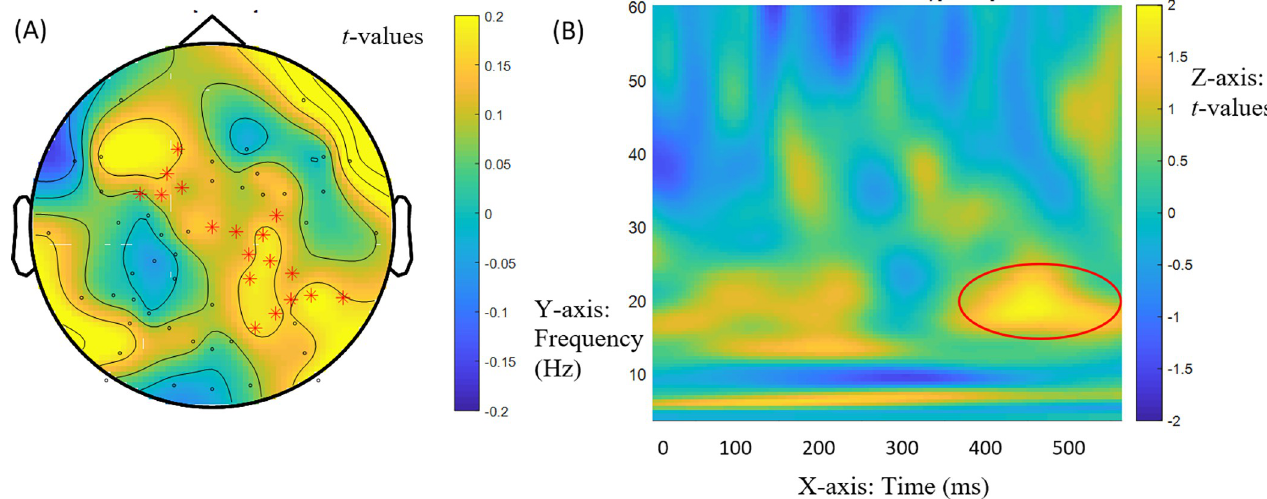
Fig 4. Group effects at subordinator que ‘that’ at 14-21Hz (beta band). (A) Group differences for the Mod-Comp contrast across antecedent match and mismatch [(2a+c)—(2b+d)] in induced power at subordinator que ‘that’ at 14-21Hz (beta band) between 382 and 562ms. The red marks indicate the electrodes for these effects (electrodes ‘E4’, ‘E9’, ‘E10’, ‘E11’, ‘E12’, ‘E13’, ‘E40’, ‘E41’, ‘E42’, E46’, ‘E48’, ‘E49’, ‘E50’, ‘E51’, ‘E52’, ‘E53’, ‘E54’, ‘E57’). (B) Time (x axis) frequency (y axis) plot of induced power differences (z axis) in groups. The circled area shows the effects.